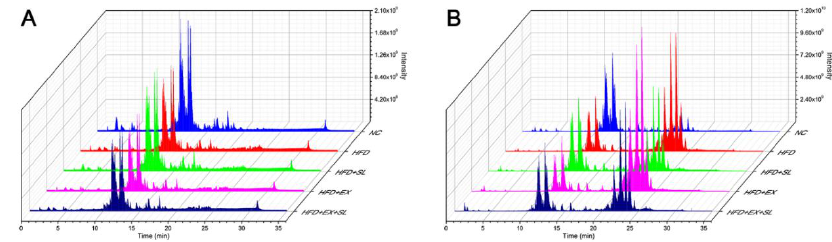
Figure 3. Representative total ion current chromatograms of the five groups in negative ion mode ( A ) and positive ion mode ( B ). Molecules 2019 , 24 , x FOR PEER REVIEW